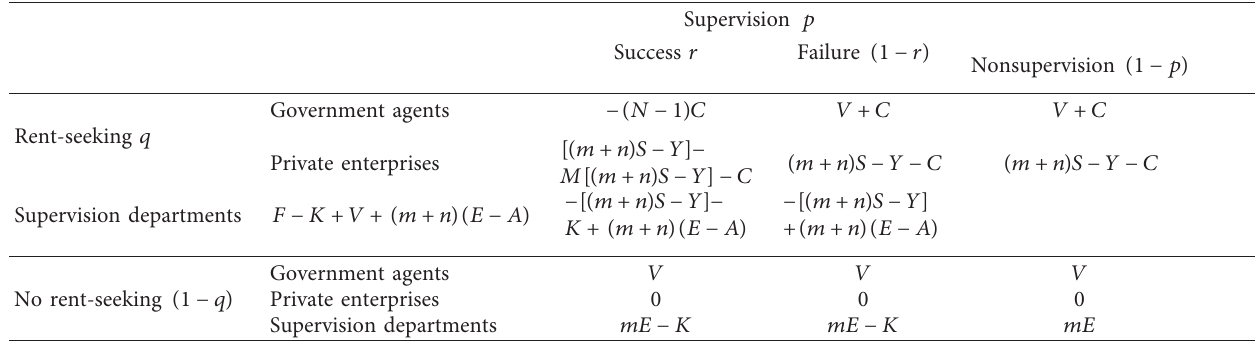
Table 1: Income matrix of government agents, private enterprises, and government supervision